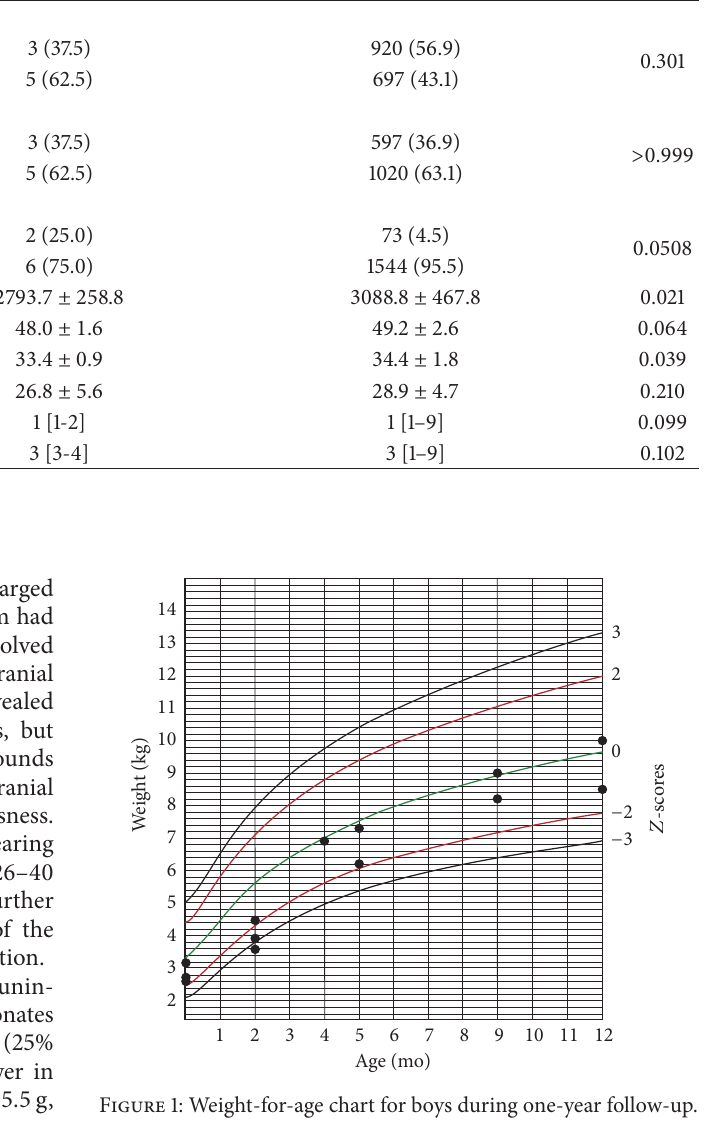
Table 2: Comparison of maternal and neonatal characteristics between Cytomegalovirus -infected and uninfected infants. Characteristics